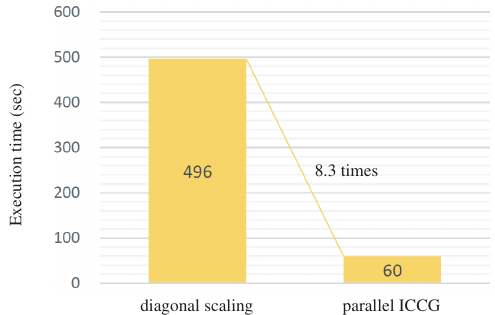
Figure 18. Execution time for the 101 × 101 × 102